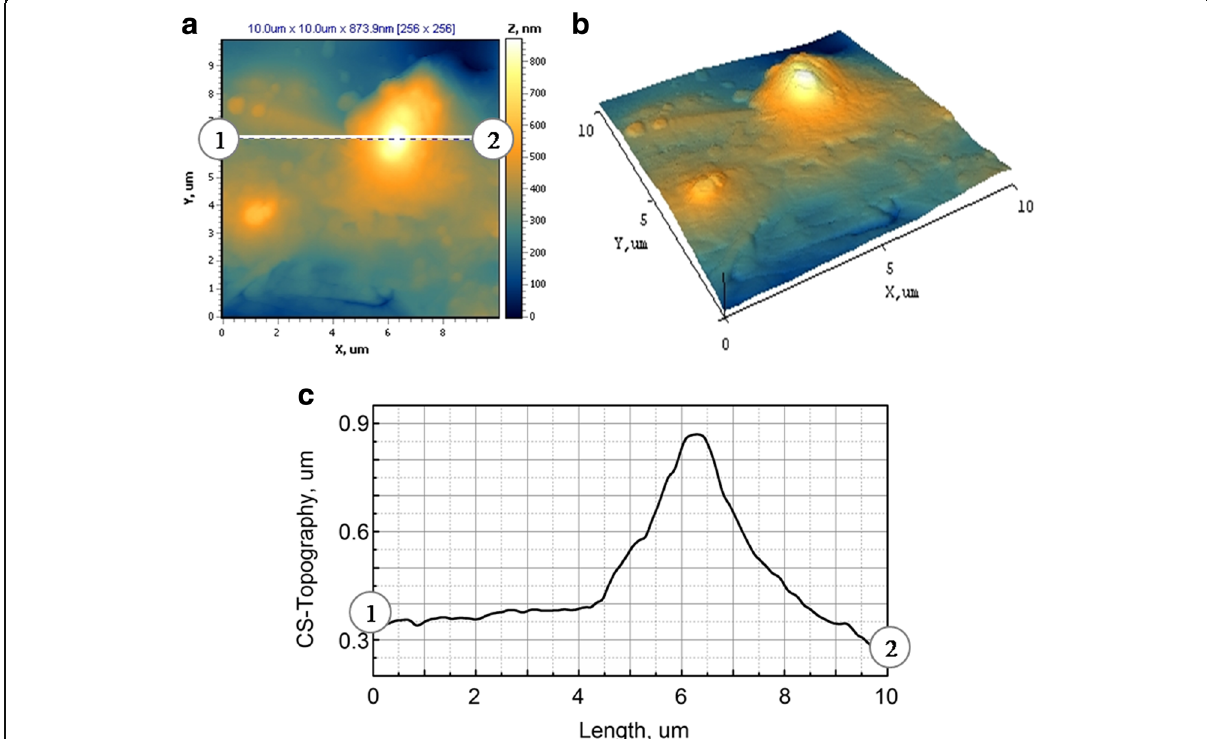
Fig. 10 a 2D and b 3D maps of the surface and c cross-sections between markers 1 and 2 for part A of Fe-Co-Mo coating with thickness of 10 μ m